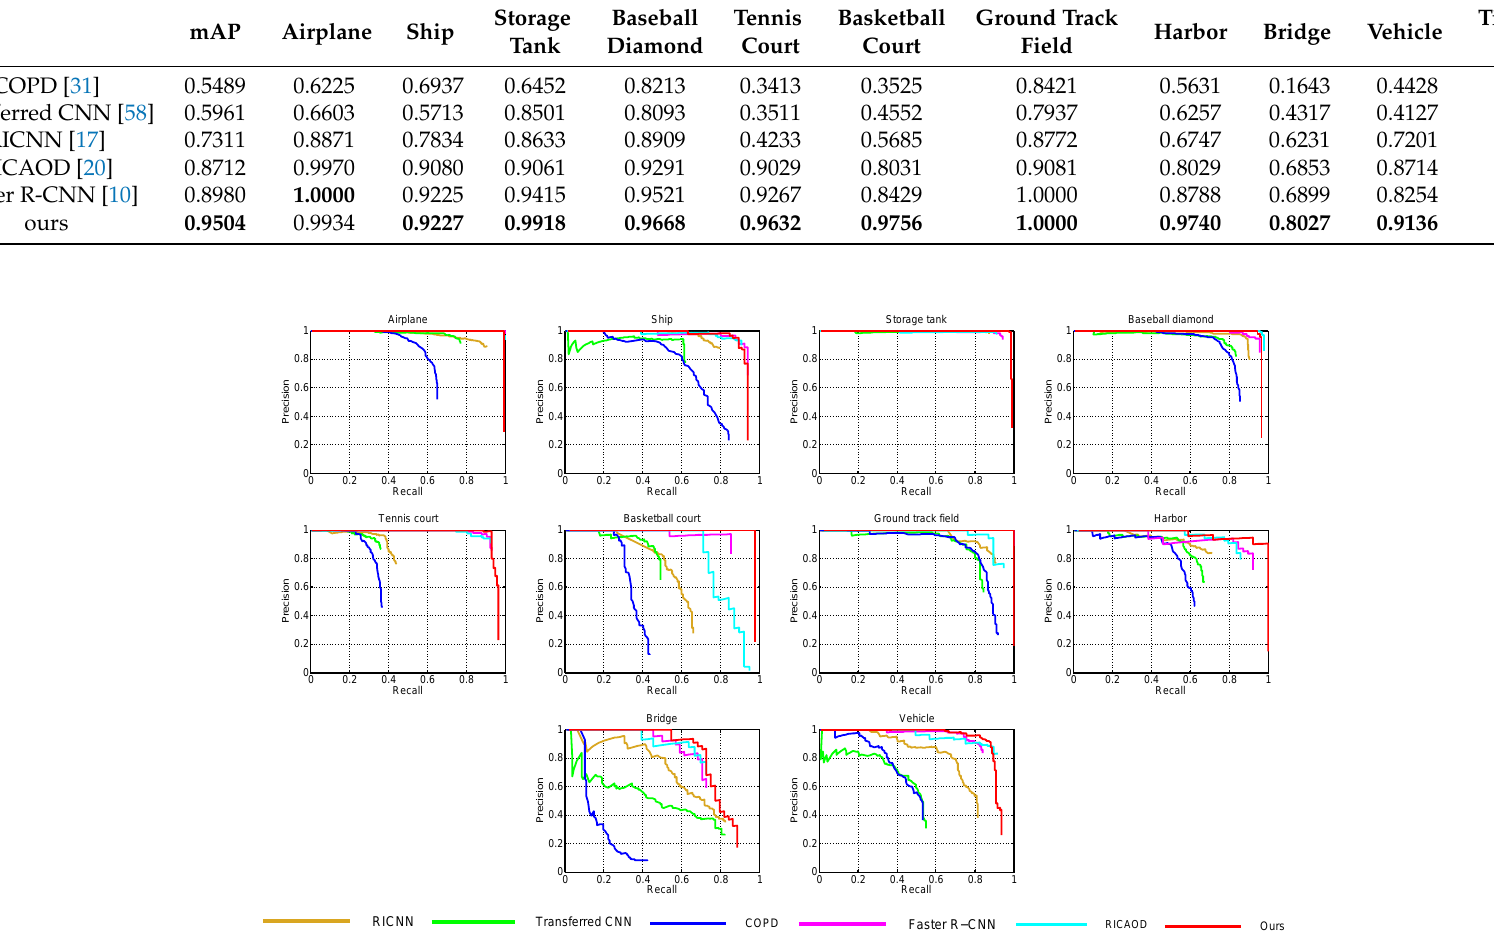
Figure 6. Precision-recall curves (PRCs) of the proposed method and other state-of-the-art methods for airplane, ship, storage tank, baseball diamond, tennis court, basketball court, ground track field, harbor, bridge, vehicle classes,